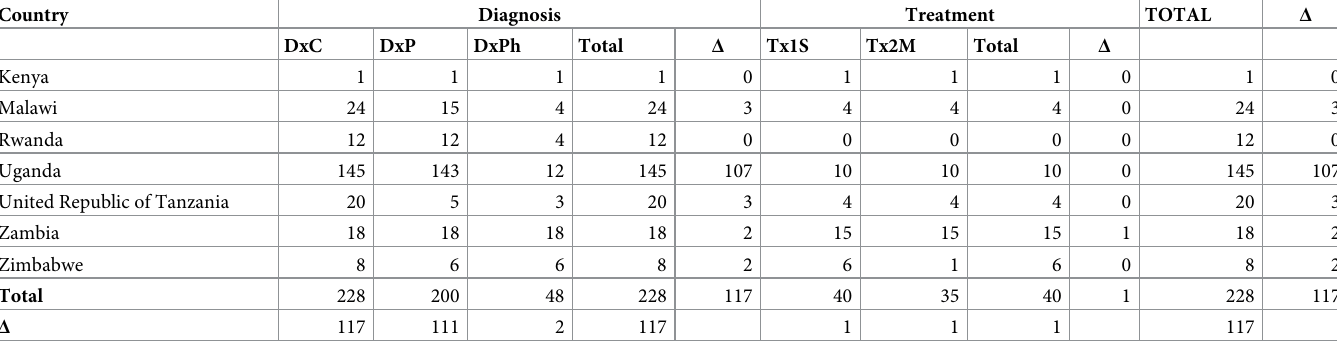
Table 4. Fixed health facilities for rhodesiense HAT: June 2021 survey. Differences from the July 2019 survey [7] in column ‘ Δ